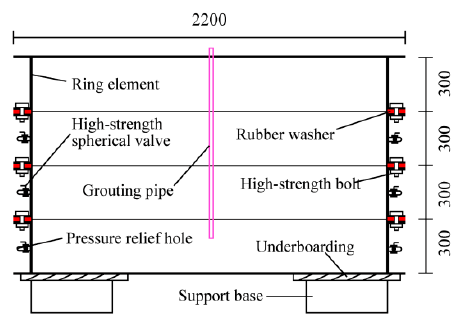
Figure 2. Structure diagram of model test bench.